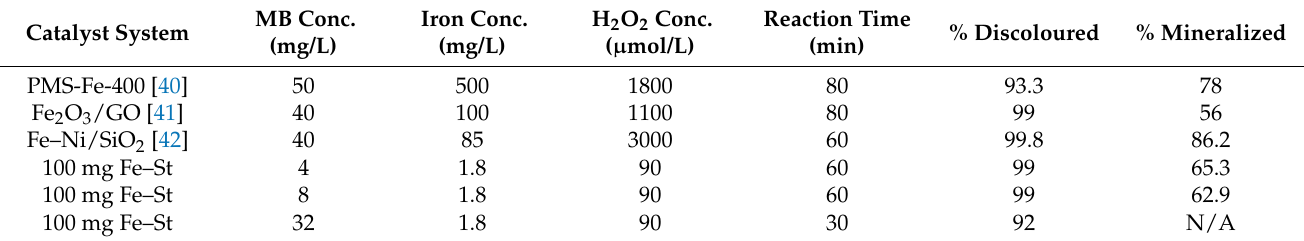
Table 4. Comparison of the performance of Fe-based heterogeneous photo-Fenton catalysts for the degradation of methylene blue reported in the literature and in this